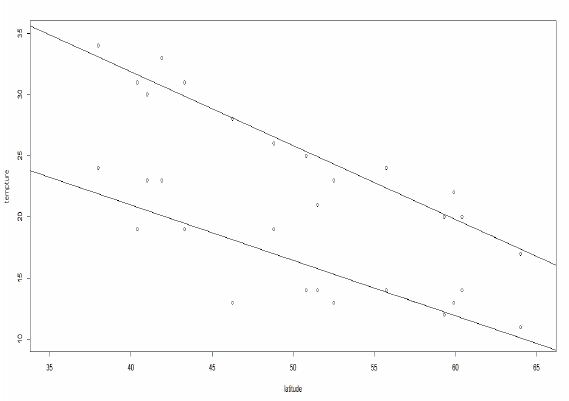
Fig. 4. Data and linear relationship of temperature and lat- itude of 15 cities in Europe on 14 August, 2012. The two lines represent the interval-valued linear regression function y = [ 39 . 03 − 0 . 45 x , 56 . 01 − 0 . 60 x ] .